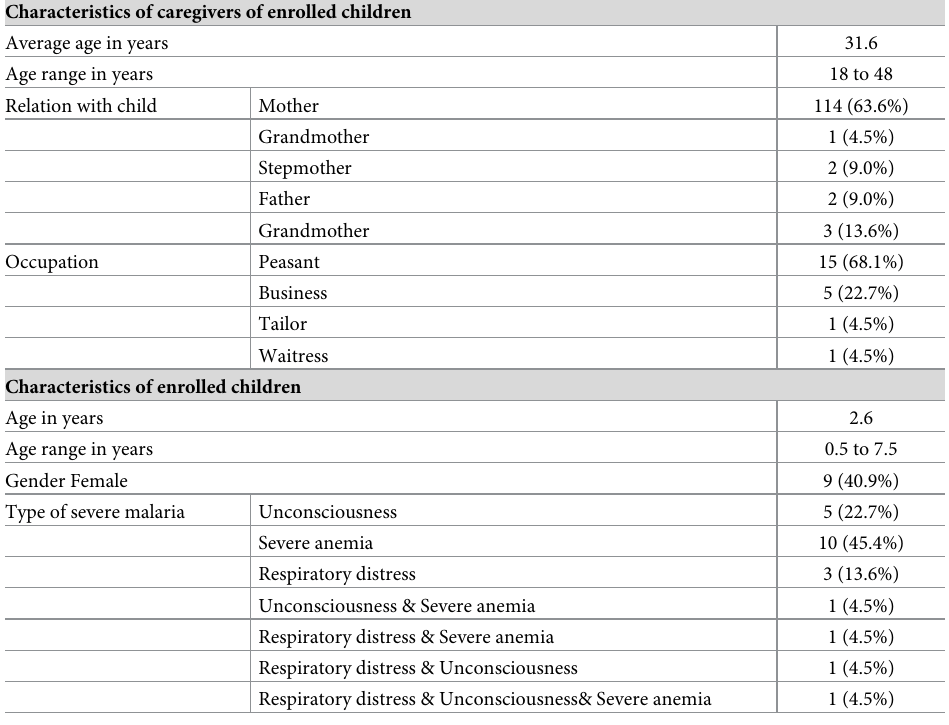
Table 1. Demographic and clinical characteristics of caregivers and their enrolled children. Characteristics of caregivers of enrolled